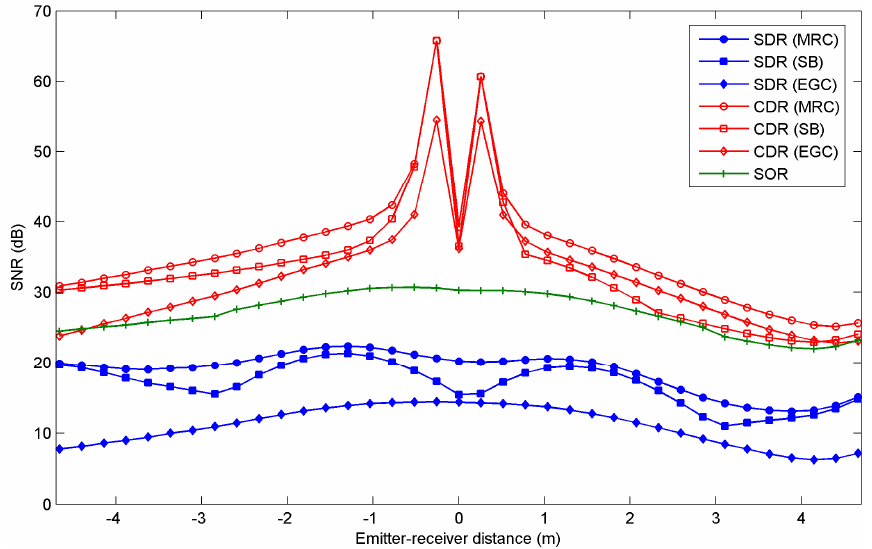
Figure 7. SNR for the sectored angle-diversity receiver (SDR), the conventional angle-diversity receiver (CDR) and the self-orienting receiver (SOR) as a function of the emitter-receiver distance along the northwest- southeast diagonal.